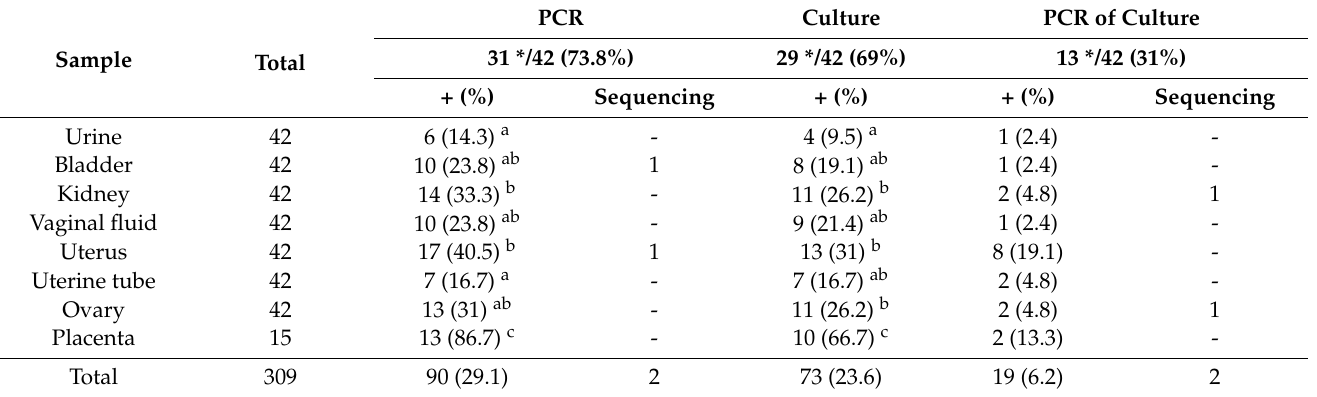
Table 2. Leptospira spp. molecular and microbiological diagnoses according to different types of biological material from cattle from the Caatinga biome,